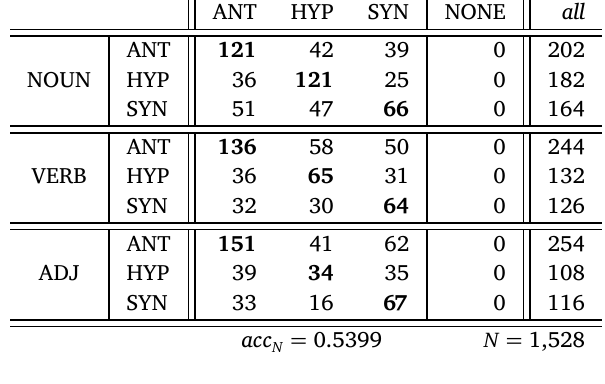
Confusion matrix for class assignment using frequency-based WINDOW-PROD